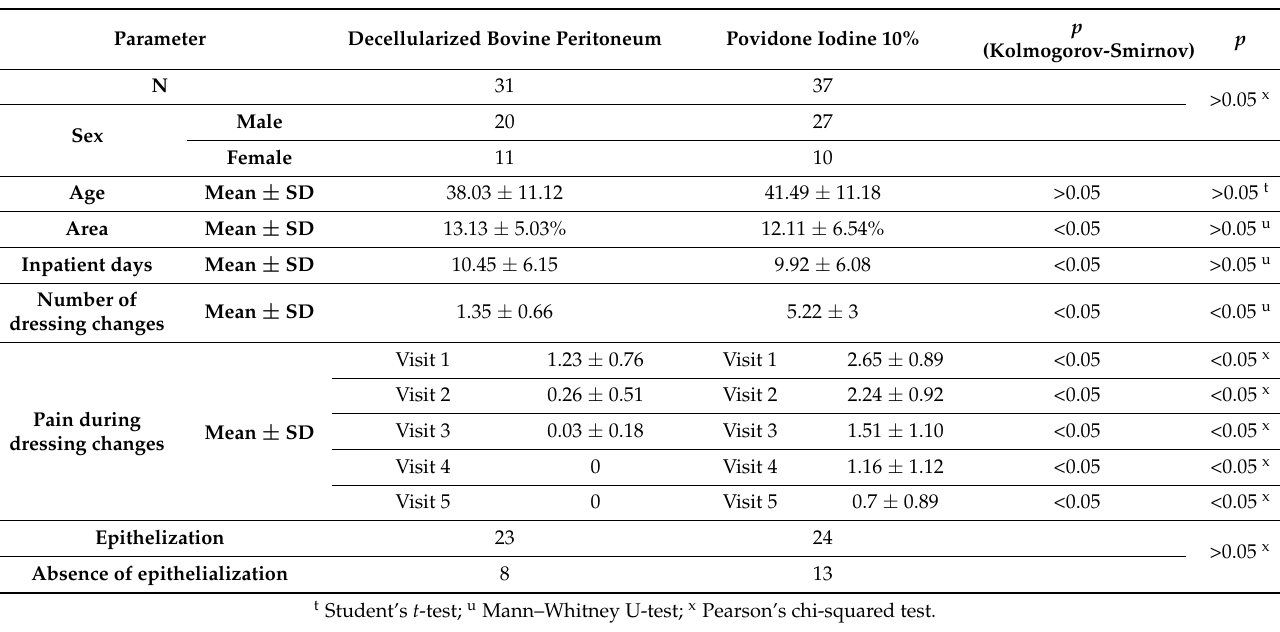
Table 2. Clinical Research Statistics.